Question: Produce a descriptive caption suitable for publication.
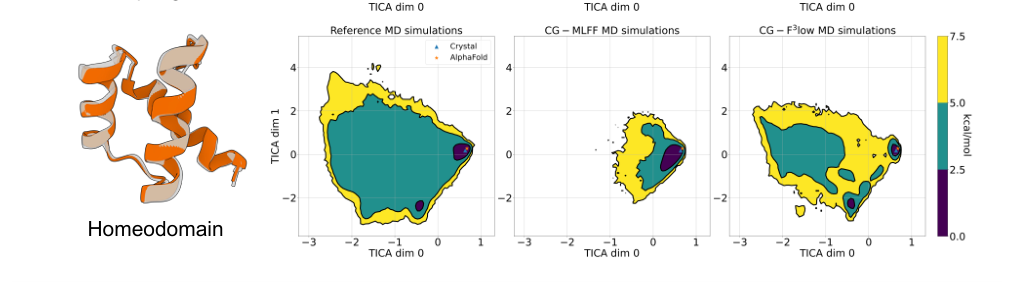
Answer: Comparison of free energy surface across reference, CG-MLFF and CG-F3low simulations. The crystal structure (gray) and the lowest RMSD structure in CG-F3low simuluation (colored) are presented on the left, respectively. The corresponding Min. RMSD can be found in Table 1.